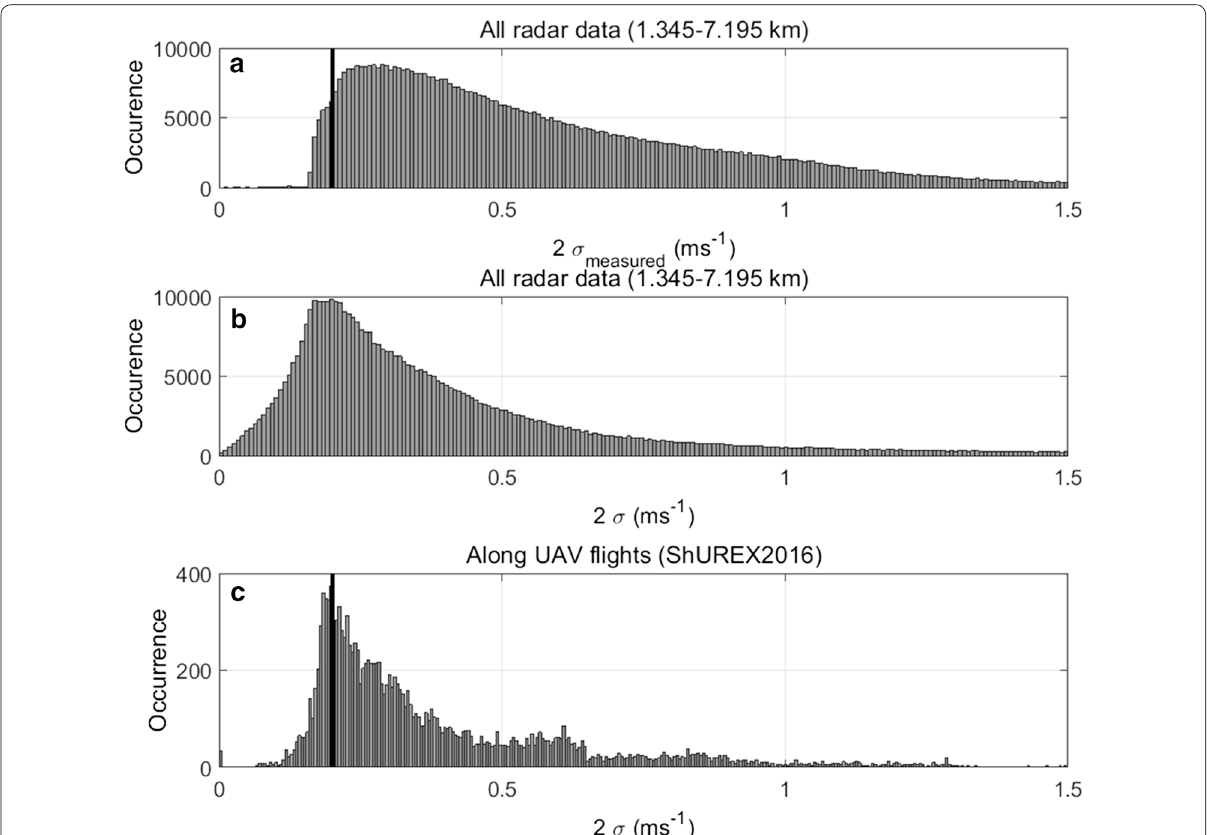
Fig. 3 a Histogram of the measured spectral width (m s − 1 ) for all the available radar data surrounding the 2016 UAV flights between 1.345 and 7.195 km (corresponding to the first 40 gates). b The corresponding histogram of 2 σ (after beam-broadening correction). c The histogram of 2 σ calculated along the 2016 UAV flight